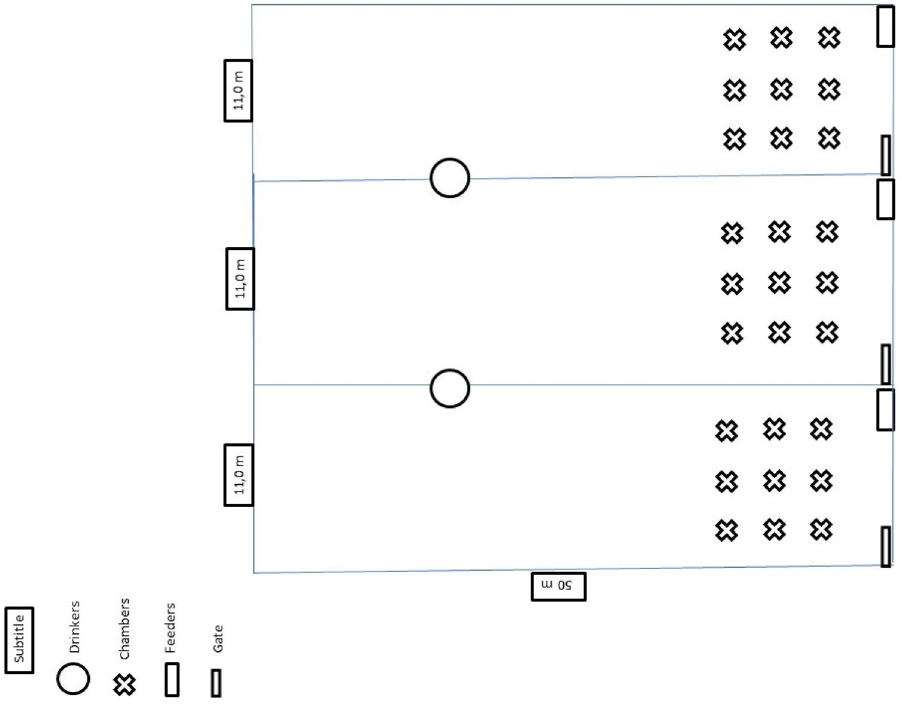
Figure 6. Map of the experimental